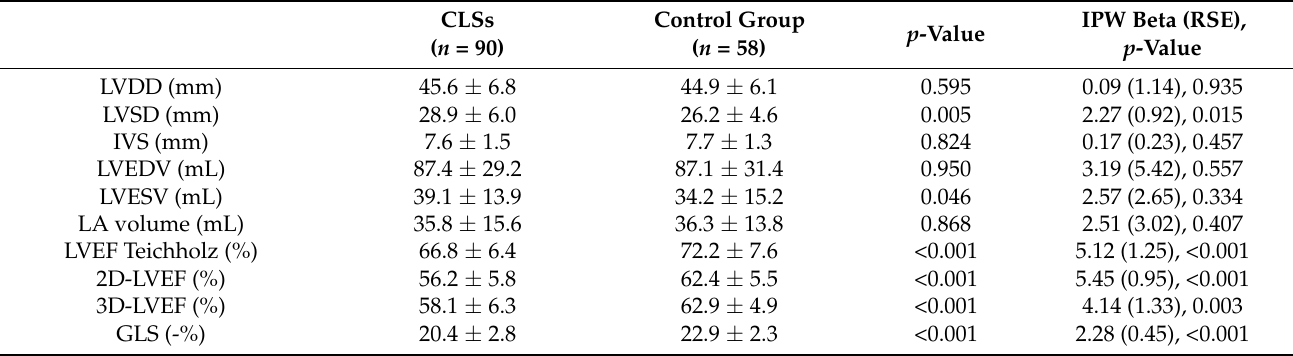
Table 2. Echocardiographic parameters of childhood leukemia survivors and